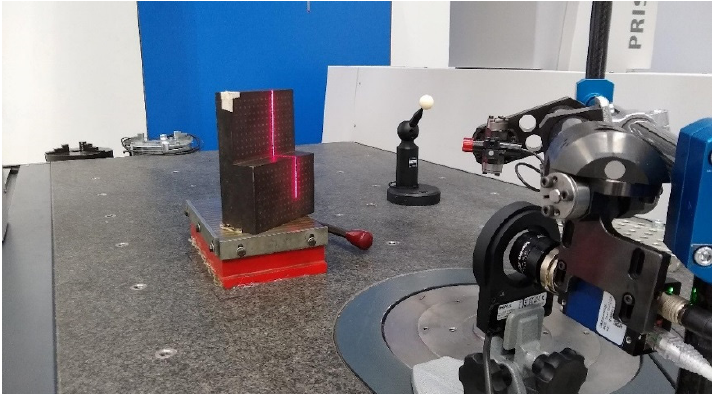
Figure 5. Laser calibration in the coordinate measurement machine (CMM) and the three-dimensional (3D) pattern for laser line detection. The 3D pattern position is obtained by the CMM stylus and the laser is calibrated by displaying the laser line onto its surface while the camera captures images.